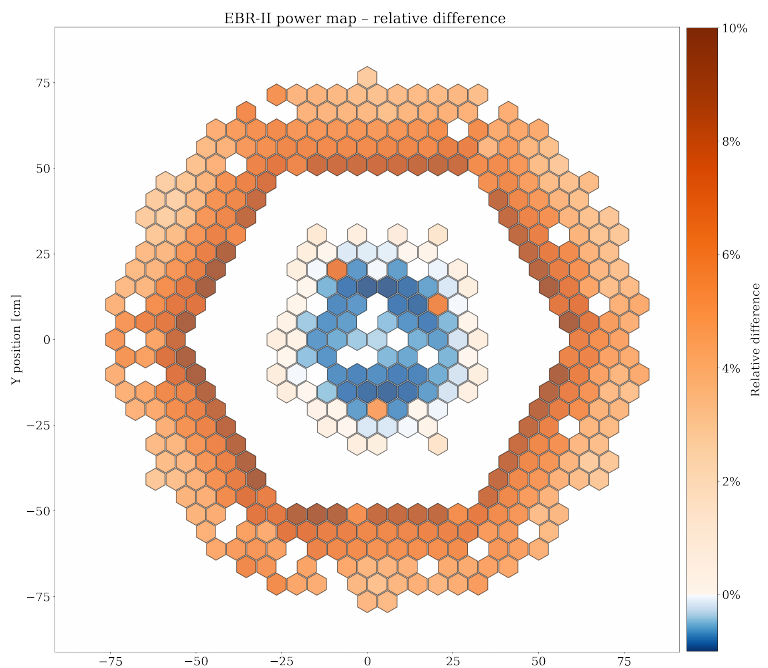
Figure 10. Relative difference between the KENO-MG and KENO-CE calculation of the axially integrated assembly powers using ENDF/B-VII.1 data. Note the different range for the positive and negative parts of the color